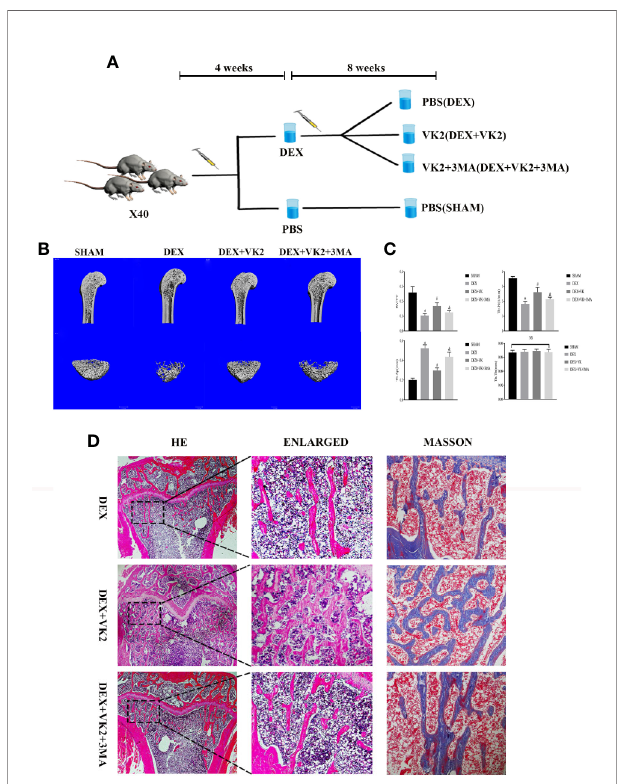
FIGURE 5 | VK2 against Dex-induced bone loss (GIOP) in rats. (A) Schematic of experimental animal arrangement in this study; (B) Micro-CT images of the longitudinal sections of the distal femurs were taken; (C) Quantitative analysis results of BV/TV, Tb.N, Tb.Sp, and Tb.Th were divided into four groups; (D) H&E staining and Masson ’ s staining of metaphyseal tissue sections of femurs. Data was expressed as mean ± SEM, *p < 0.01 vs SHAM group, # p < 0.01 vs. DEX group, & p < 0.01 vs. DEX+VK2